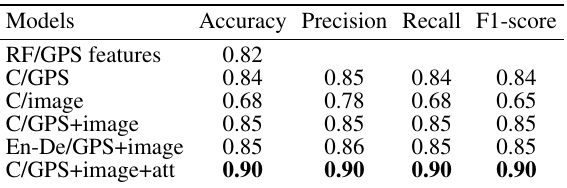
Table 5. Arm rule detection results of different